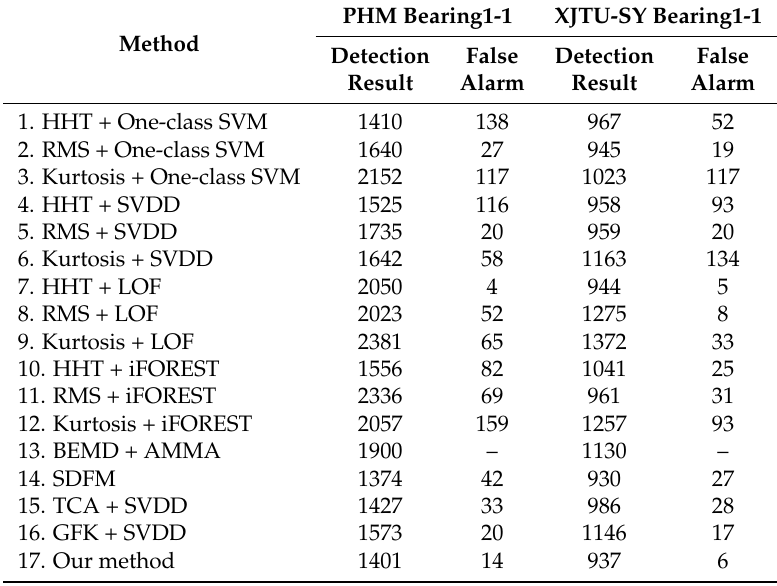
Table 4. Comparison of early fault detection results on the datasets of IEEE PHM Challenge 2012 and